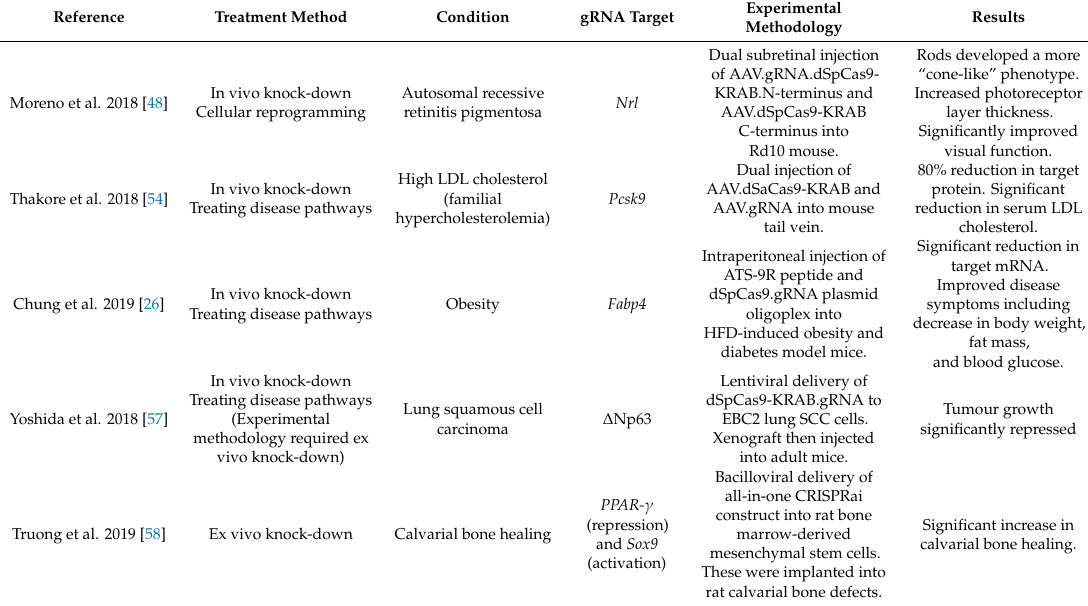
Table 3. In vivo gene therapy CRISPRi